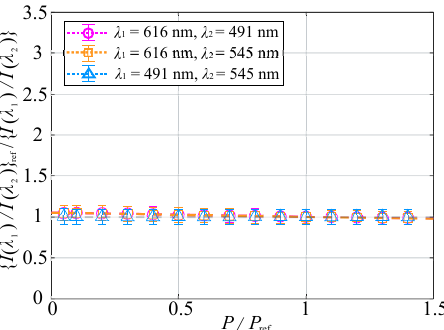
Figure 16. Normalized ratio of the emission intensities at two wavelengths plotted against the normalized pressure at T = 293